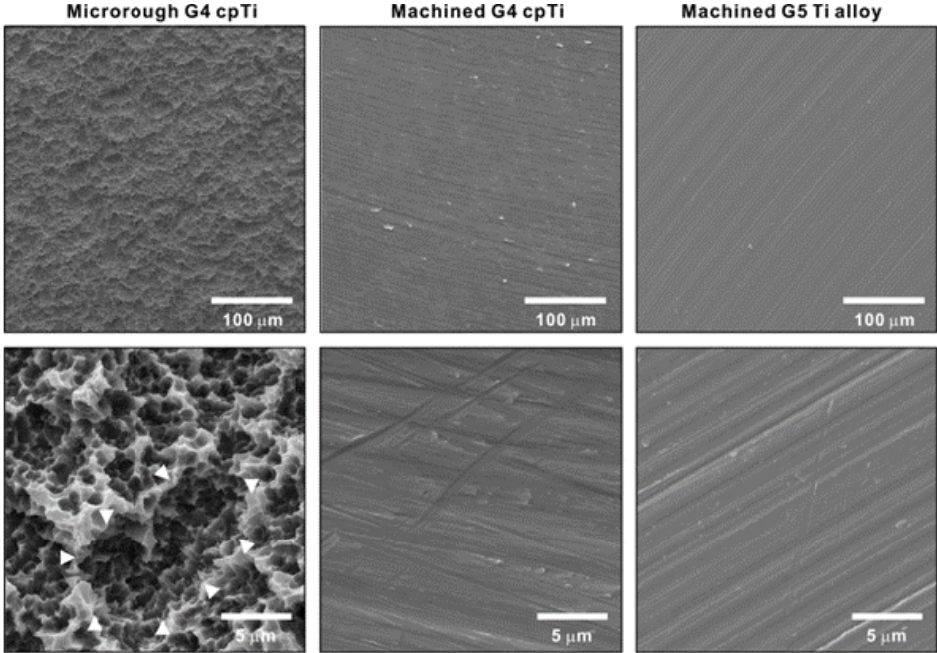
Figure 1. Surface morphology of titanium specimens used in this study. Low ( upper panels)- and high ( lower panels)-magnification SEM images of three different specimens.